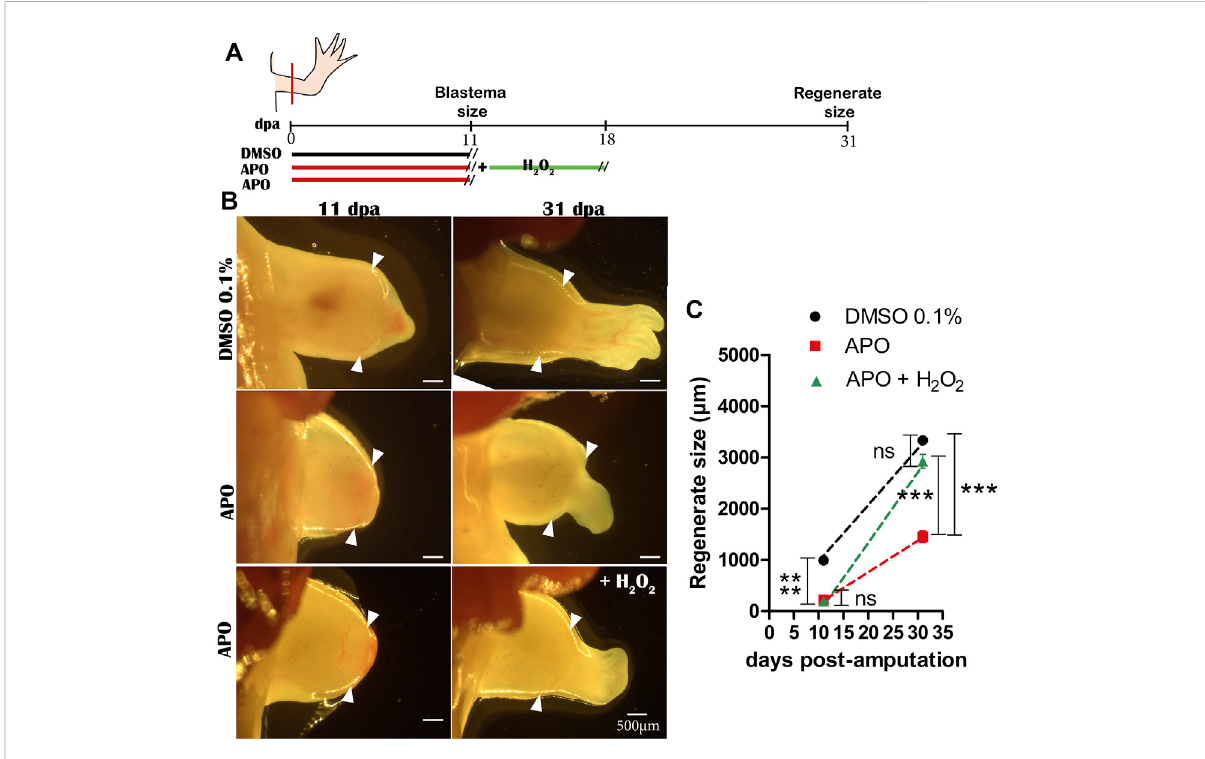
FIGURE 3 Exogenous H 2 O 2 induces a rescue effect on the regenerating structure. (A) Illustrative scheme of the rescue assay performed. (B) Representative images of regenerating tissues at 11 and 31 dpa of controls in 0.1% DMSO, inhibitory treatments with apocynin and without rescue, andinhibitorytreatmentsrescuedwithexogenousH 2 O 2 . (C) Quanti fi cationofregeneratesizeat31 dpa.Whitearrowheadsrepresenttheamputation plane. One-way ANOVA and post-hoc Tukey were performed to compare the evaluated groups ( n = 10 per group). Data are expressed